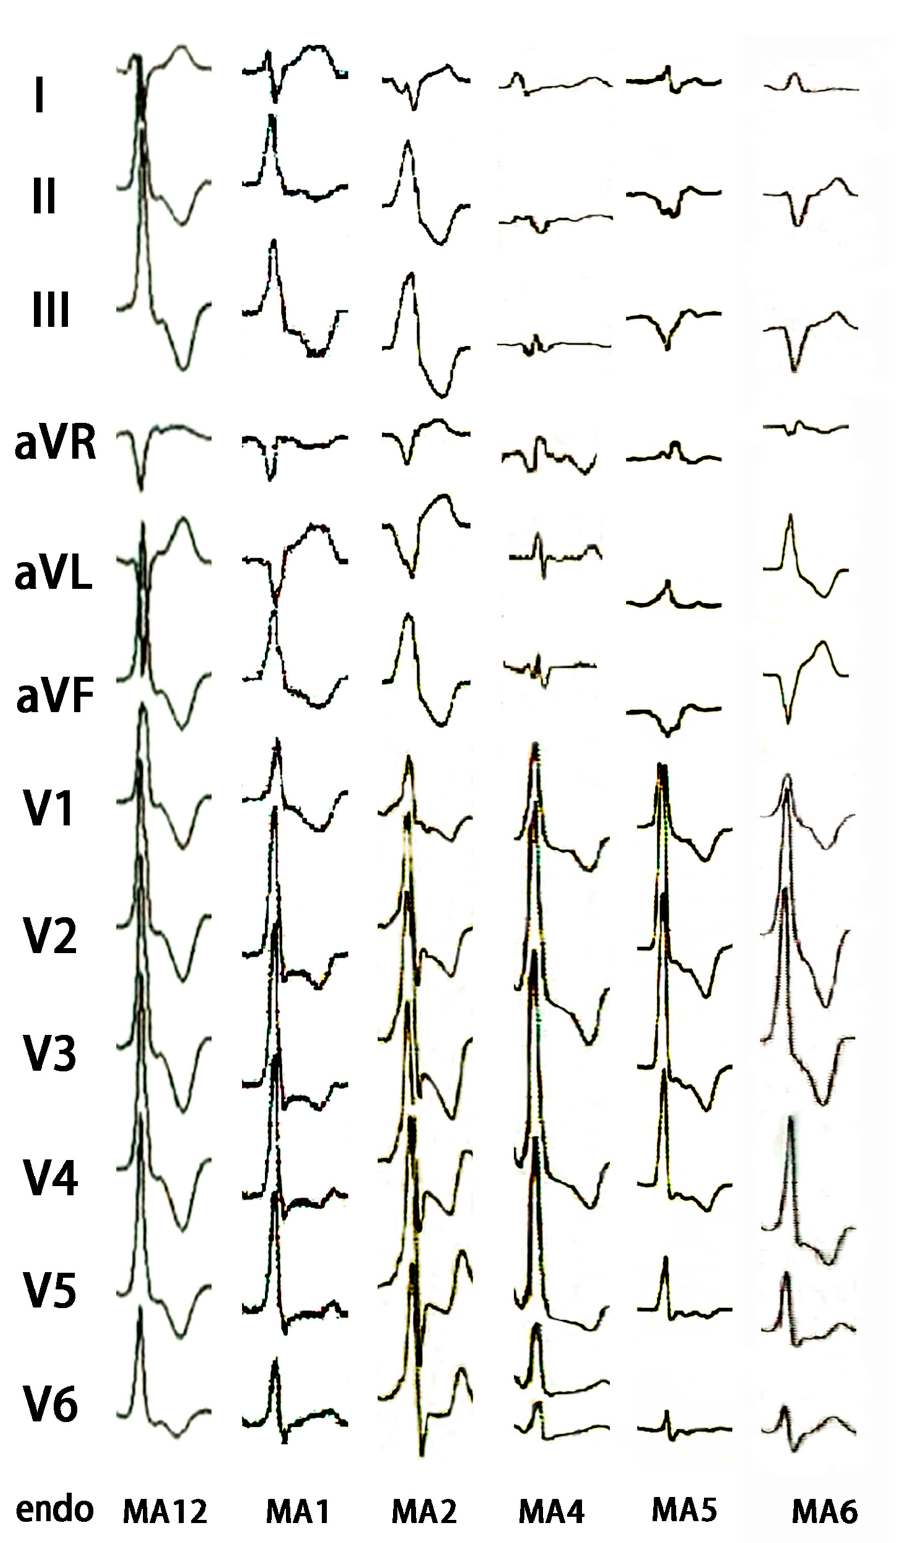
Figure 4. The QRS morphology of IVAs originating from the endocardial mitral